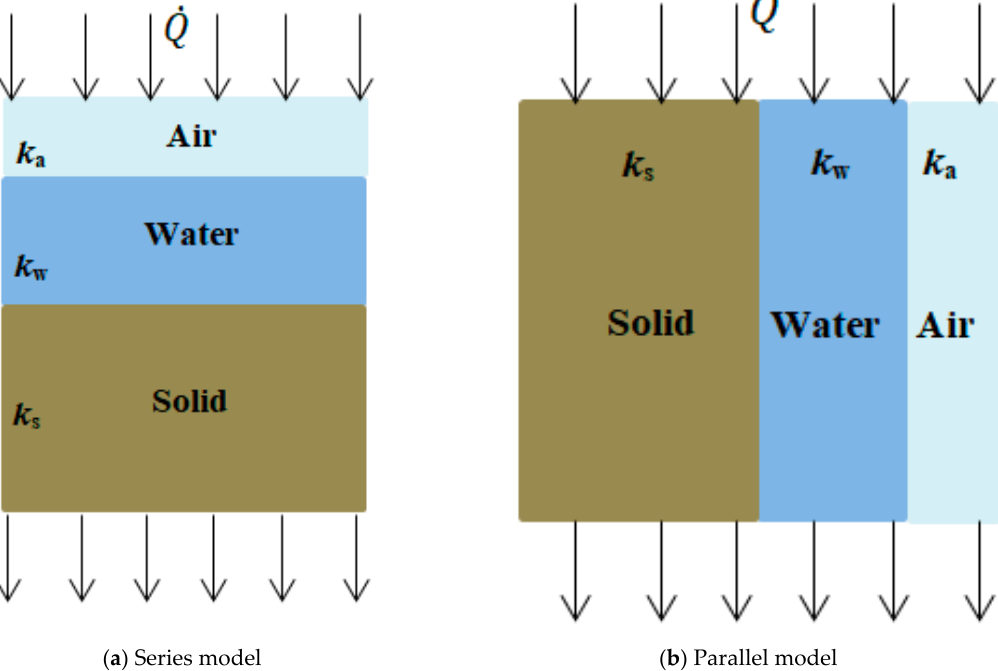
Figure 5. Schematic of the fundamental series and parallel models, used to calculate the effective thermal conductivity.